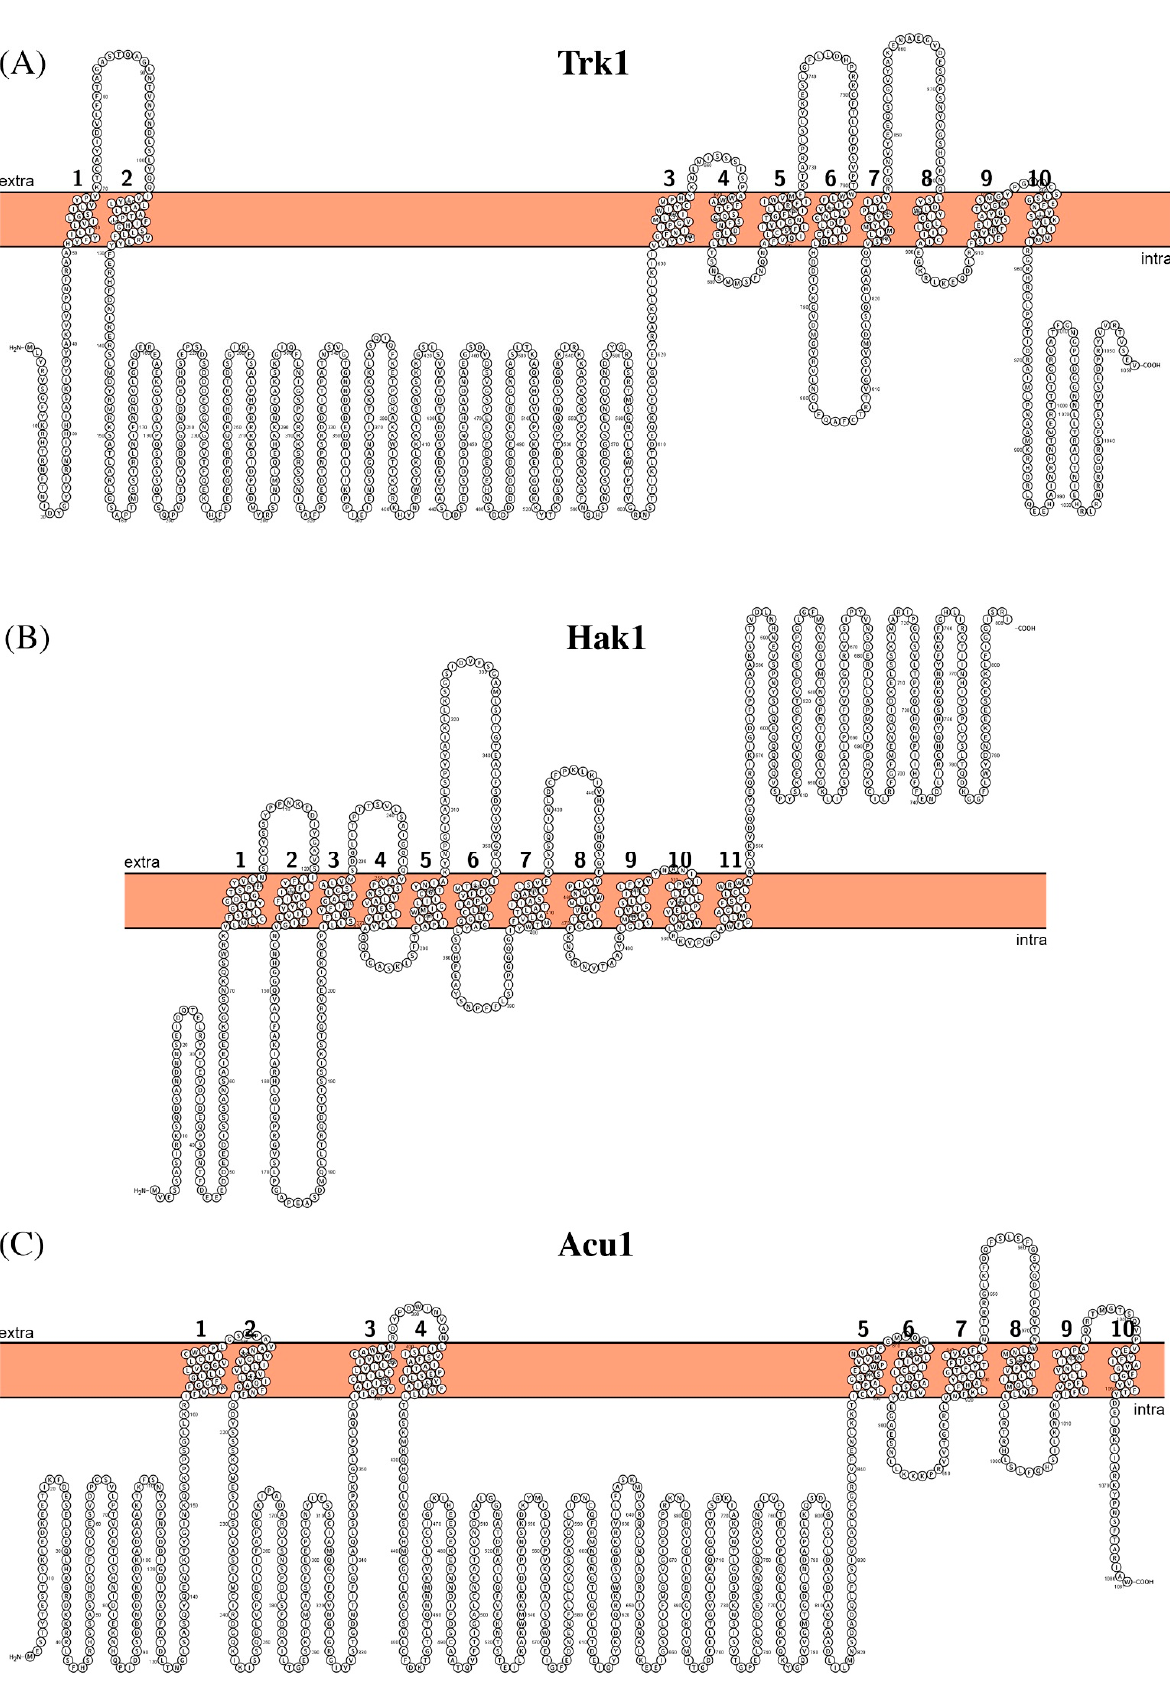
Figure 3. Schematic representation of the proposed secondary structure and topology of Trk1 ( A ), Hak1 ( B ), and Acu1 ( C ).